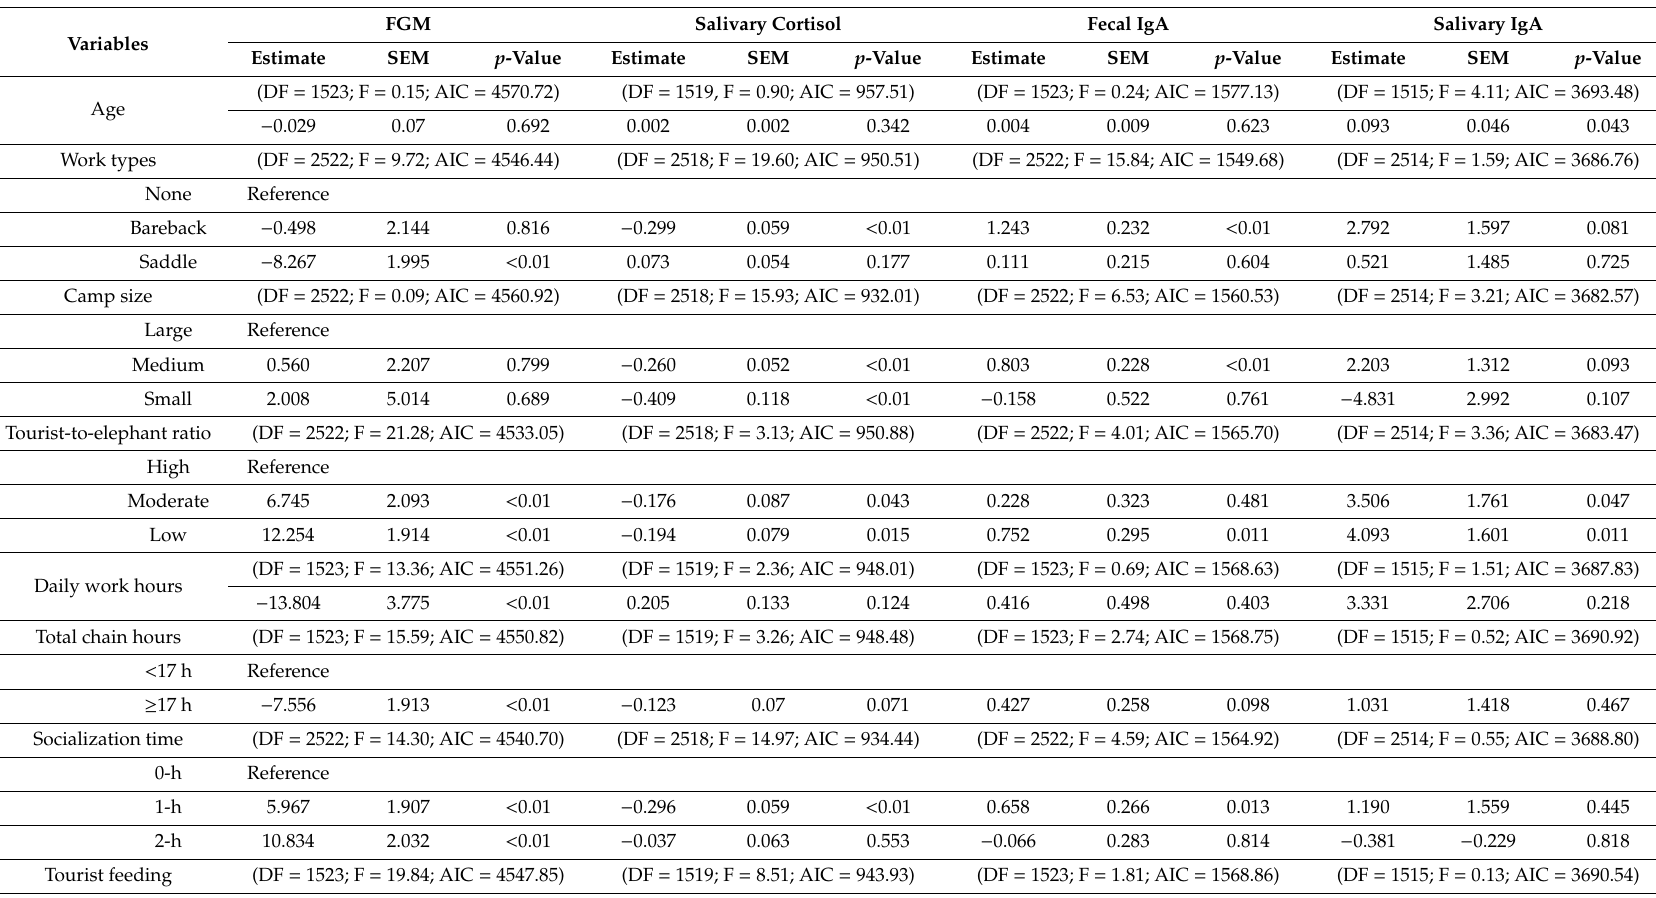
Table 2. Generalized least square analyses of work activities, season, and camp variables associated with GC and IgA